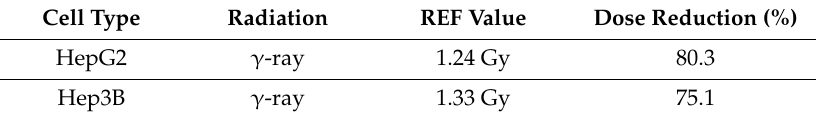
Table 4. Radiosensitivity enhancement factor (REF) and dose reduction values.